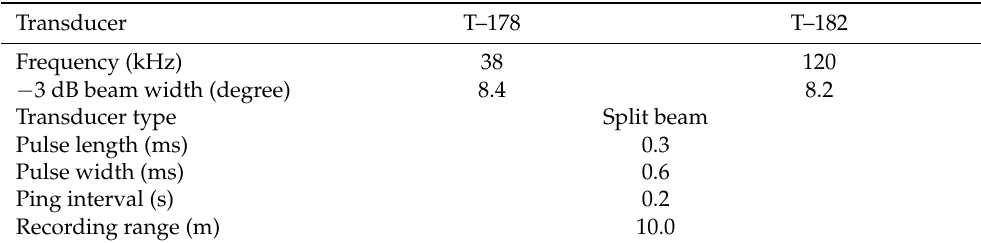
Table 2. Settings of quantitative echo sounder KSE-300 in all